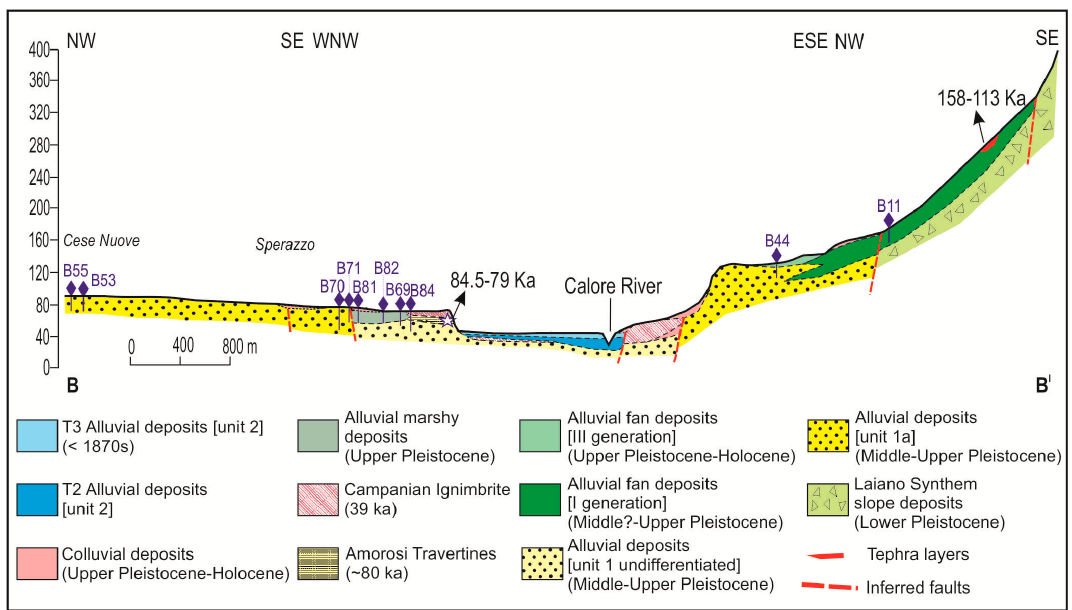
Figure 10. Schematic geological cross section through the Calore River valley in sector B. For location, see Figure 9.